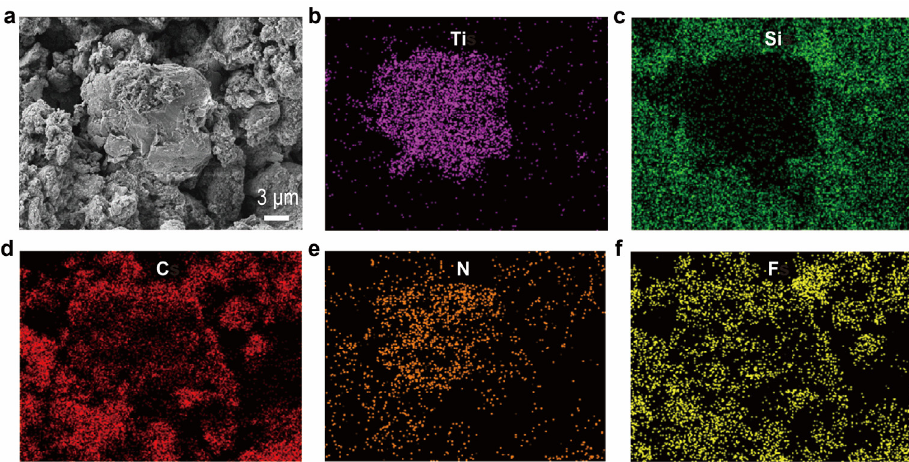
Figure 5. Surface morphology of the F-SiO 2 /MXene superhydrophobic coating after abrasion. ( a ) SEM images and ( b–f ) EDS mapping of the F-SiO 2 /MXene superhydrophobic coating after abrasion.